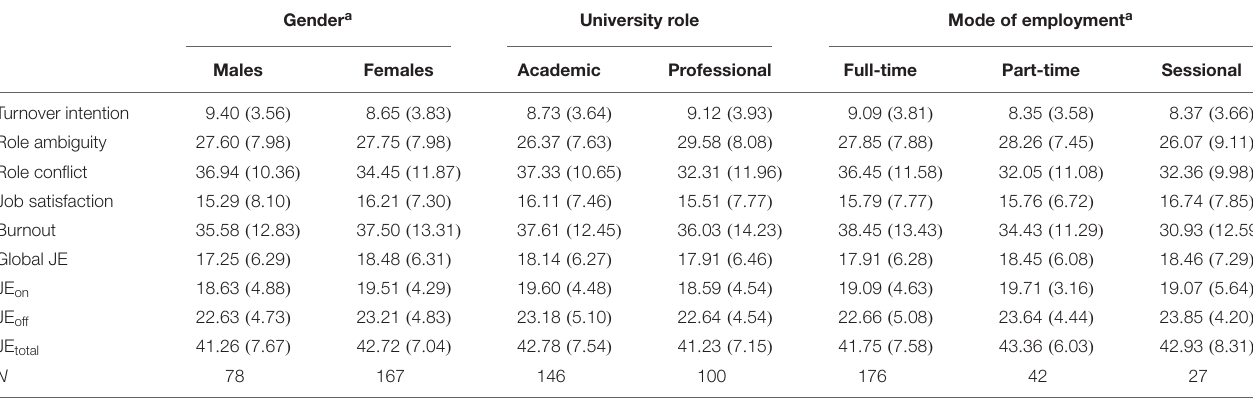
TABLE 1 | Scale means and standard deviations per demographic indicator ( N =